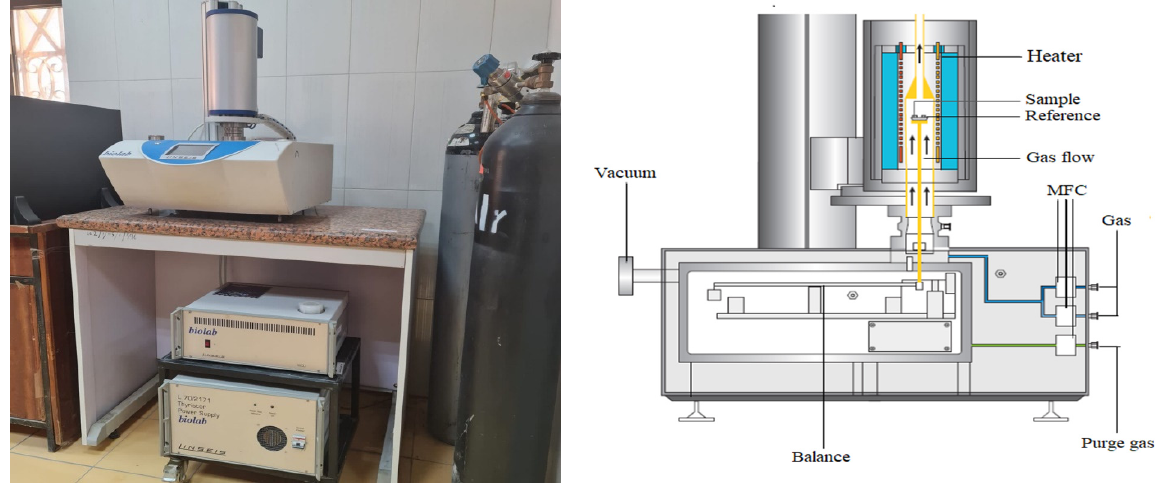
Figure 2. Pictorial view and working principle of the TGA instrument used.